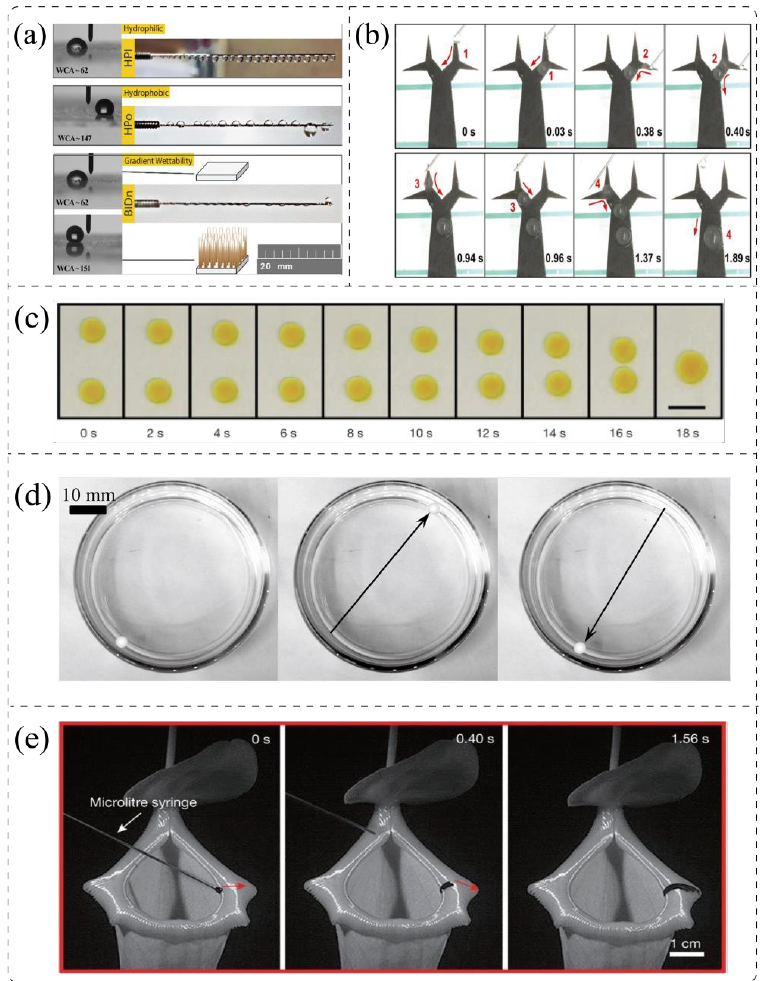
Figure 7. ( a ) Fog collection with a hydrophilic needle, a superhydrophobic needle and a bioinspired design needle respectively from top to down [96] (Reproduced with permission from American Chemical Society, 2021). ( b ) Aggregation and motion of droplets on horizontally positioned multiple-shape gradient surfaces [107] (Reproduced with permission from American Chemical Society, 2017). ( c ) Two droplets attract each other and coalesce due to the Marangoni flow (scale bar: 5 mm) [89] (Reproduced with permission from Springer Nature, 2015). ( d ) The motion of an LM containing 70 vol% aqueous ethanol solution, which is caused by the Marangoni flow of the water carrier [90] (Reproduced with permission from American Chemical Society, 2015). ( e ) Anti-gravitational droplet motion on the structure of wedge corner with an opening angle gradient [35] (Reproduced with permission from Springer Nature, 2016).